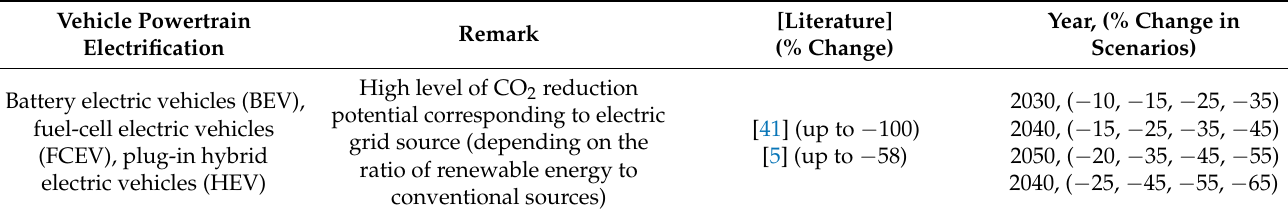
Table 2. Impacts of vehicle powertrain electrification on road transportation energy use.